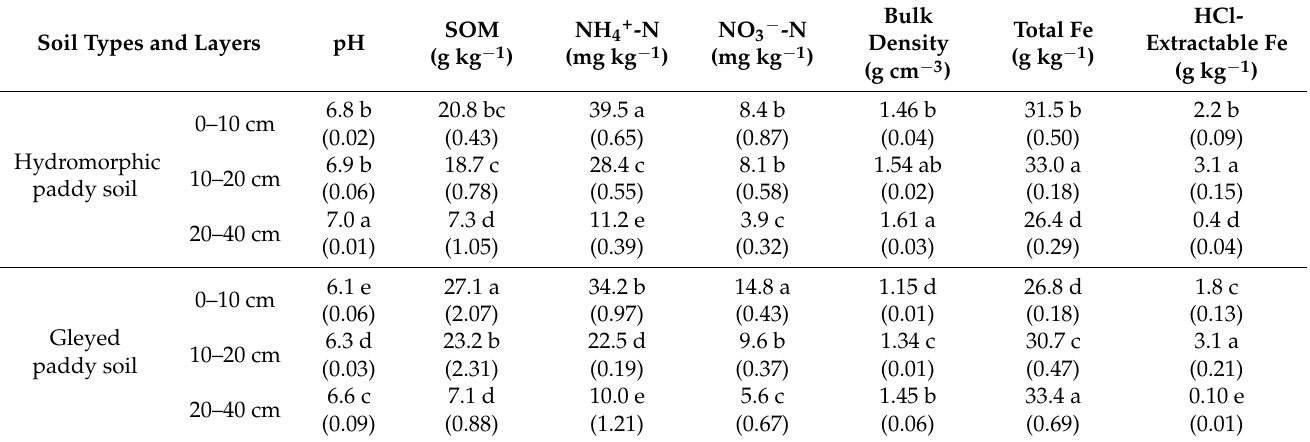
Table 1. The geochemical properties of the two paddy